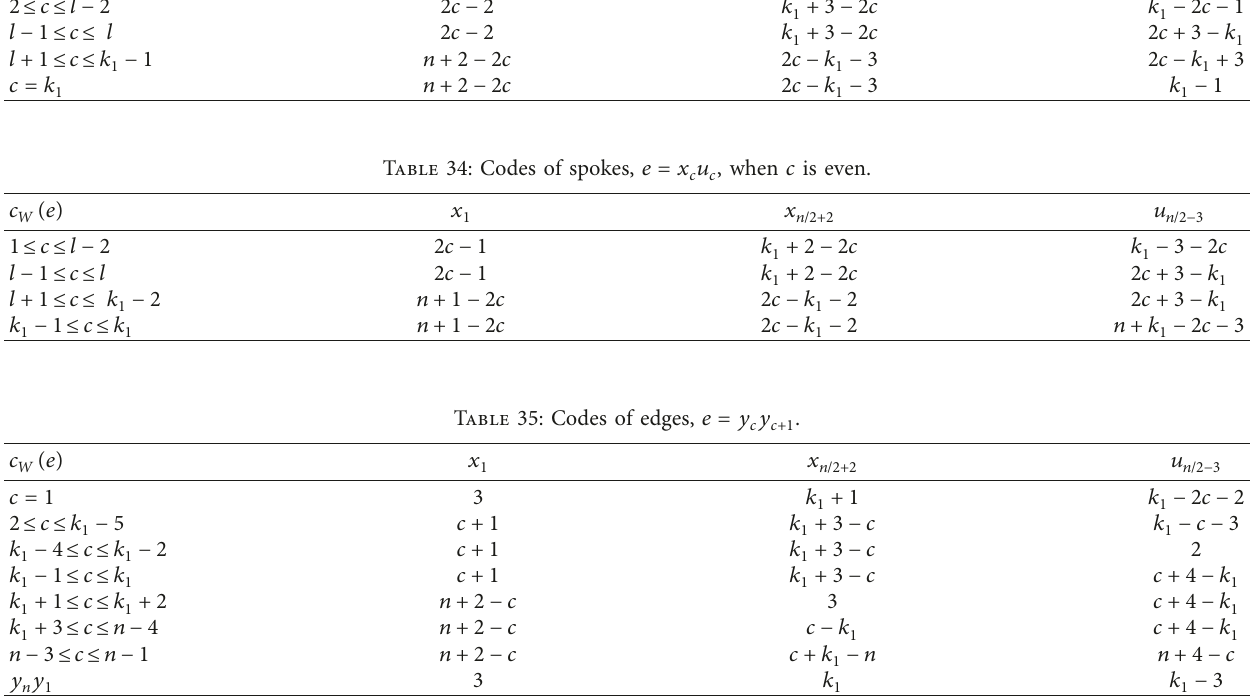
Table 36: Codes of edges, e � u